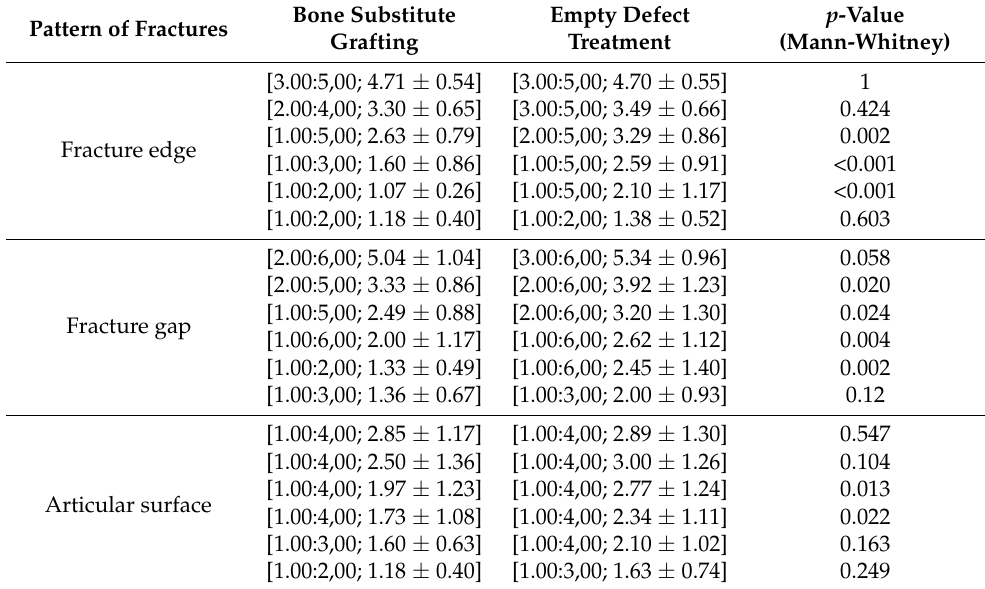
Table 2. Radiological assessment of fractures in traumatic caused geriatric fractures. Comparing the group of Empty Defect treatment (ED) with Bone substitutes material (BSM) in six follow-ups (FU)